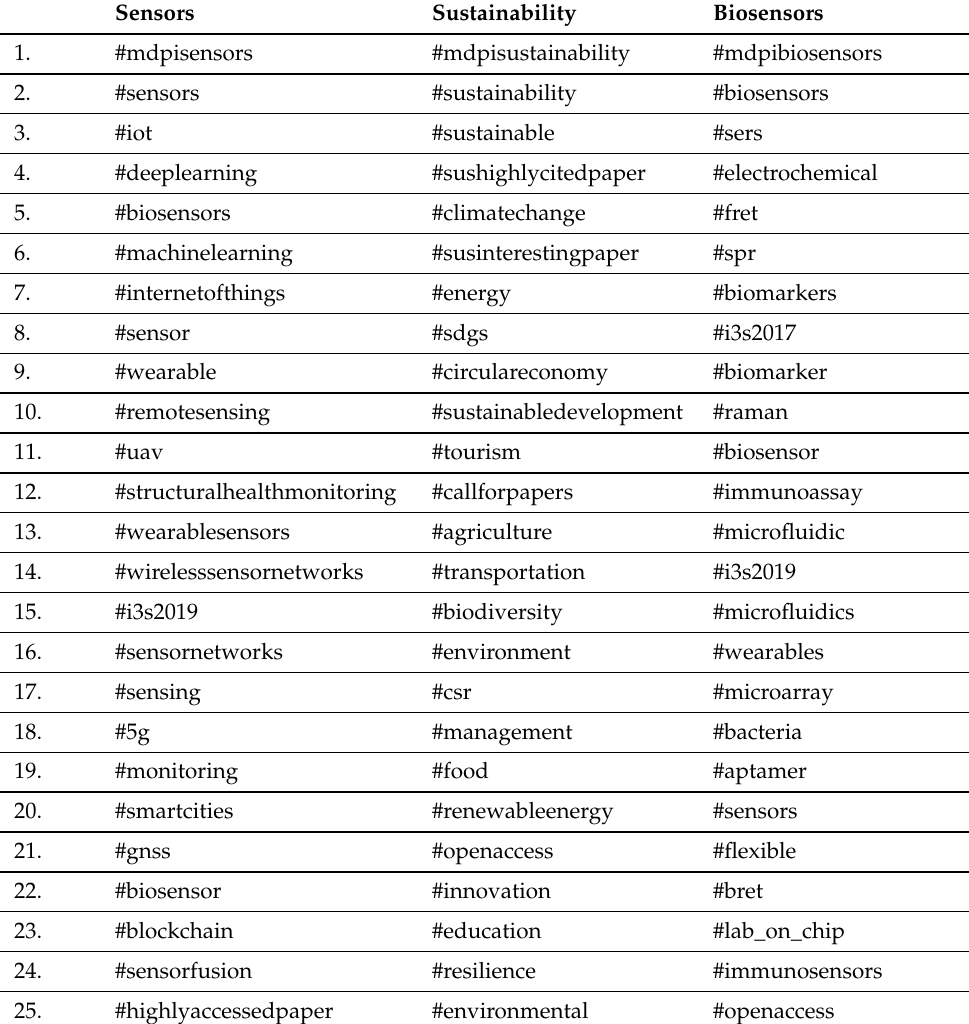
Table 1. The 25 most common hashtags of three journals for 2000 examined